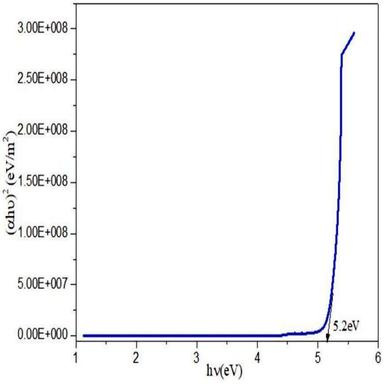
Tauc plot - G4C3NBM crystal.